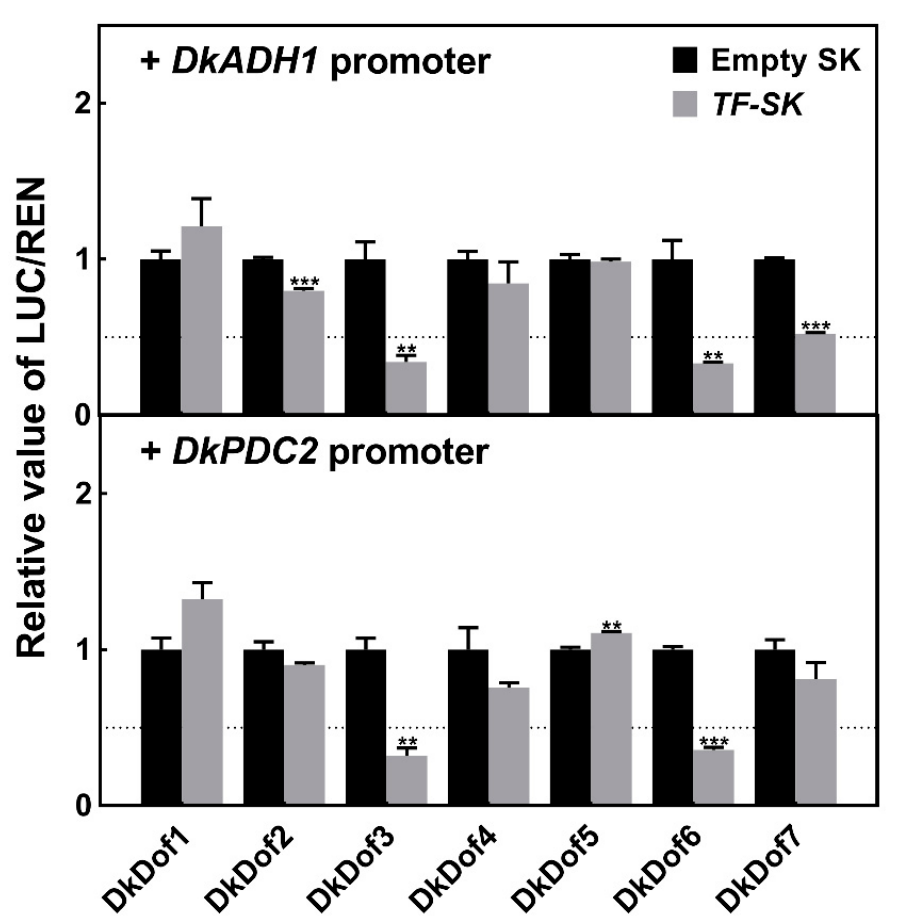
Figure 4. The regulatory effects of DkDof1-7 on the promoters of DkADH1 and DkPDC2 . Empty SK and TF -SK means empty SK plasmid and recombinant SK construct containing the TF gene, respectively. The LUC/REN value of empty SK plus corresponding promoter was set as 1. Error bars represent standard errors from three replicates (**, p < 0.01; ***, p < 0.001). DkDof2, 3, 6 and 7 inhibit the activity of the promoter of DkADH1 whereas DkDof3 and 6 inhibit activity of the DkPDC2 promoter.